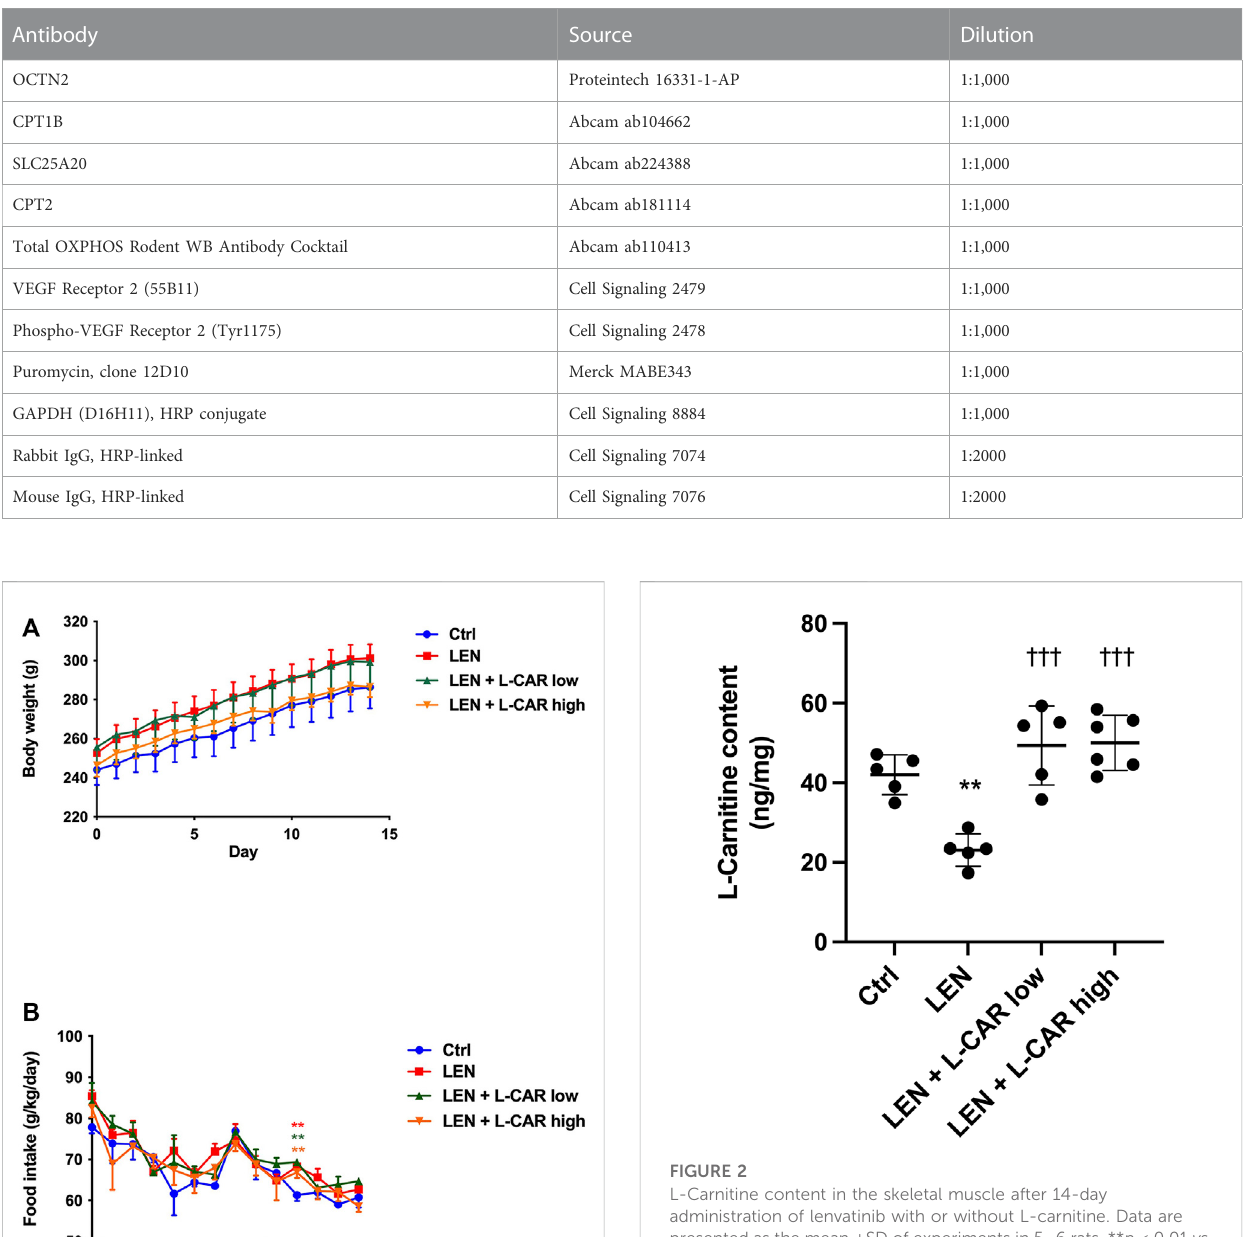
TABLE 1 Antibodies used for Western blotting.